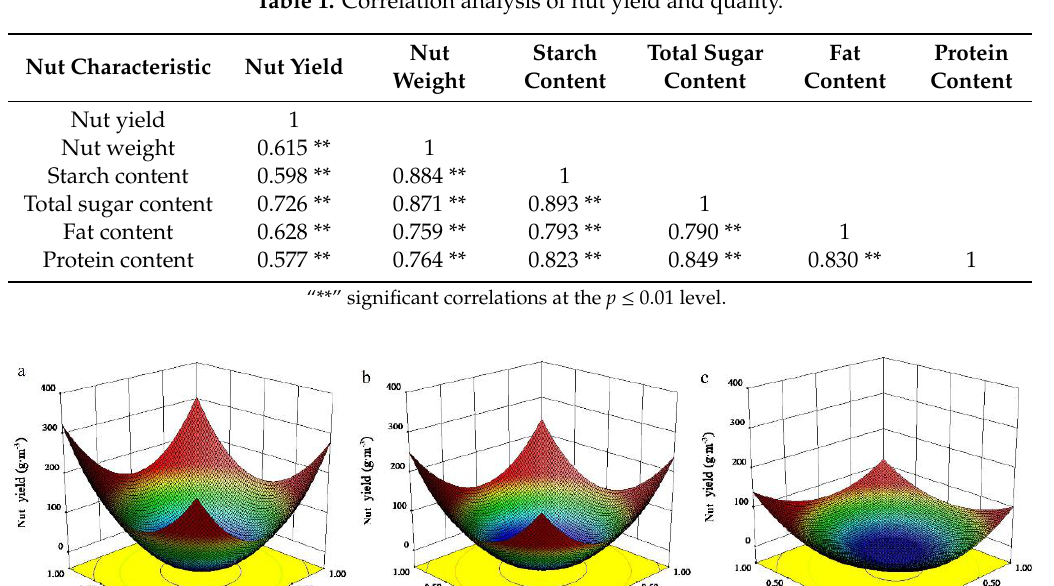
Table 1. Correlation analysis of nut yield and quality.